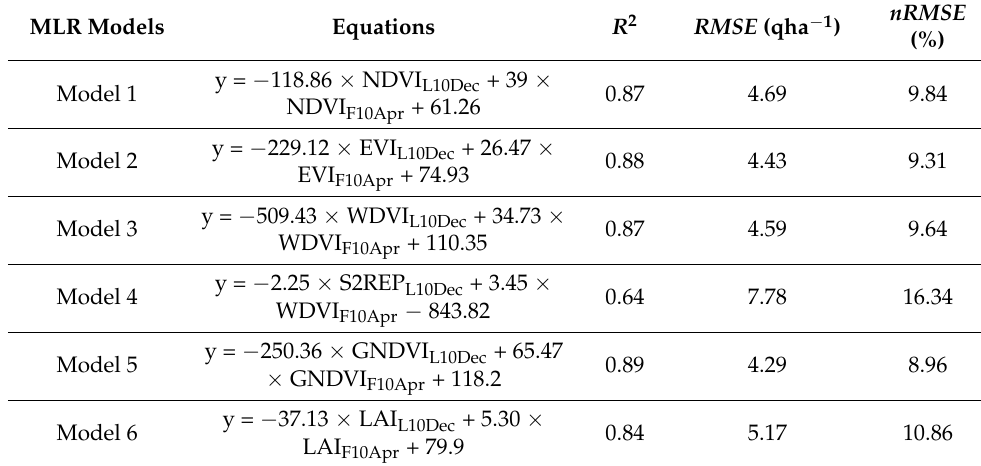
Table 4 Yield estimation models for durum wheat using remote sensing indices.